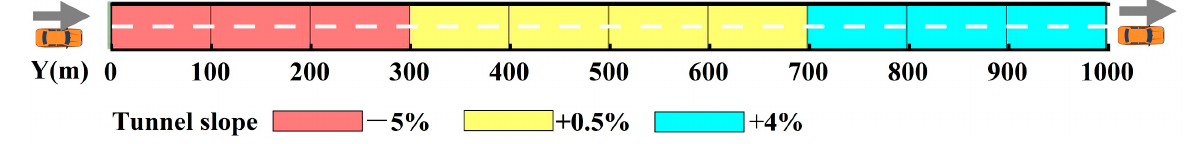
Table 1. Different velocity modes and values in tunnel